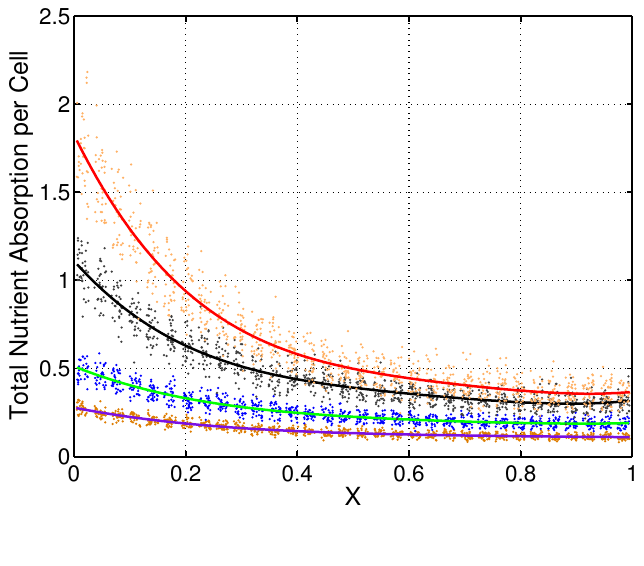
Figure 7. The effects of normal distance ( X direction) to the source of nutrients and nutrient absorption rate b on the total amount of nutrient consumed by each cell. Fourth degree polynomials were fitted to the values of total nutrient consumed by each cell in the cases b = 5 (red), b = 2 . 5 (black), b = 1 (green) and b = 0 . 5